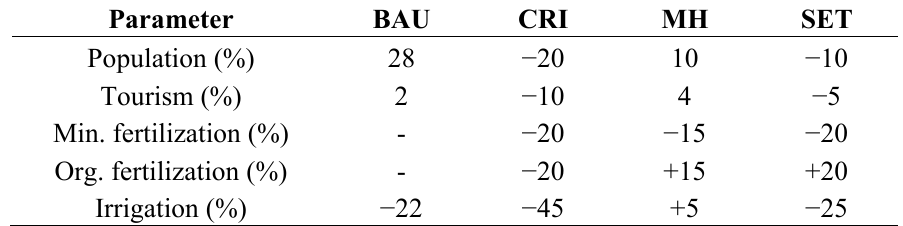
Table 2. Assumed management related relative changes in population, tourism and agricultural practices for the four socio-economic scenarios (BAU, CRI, MH and